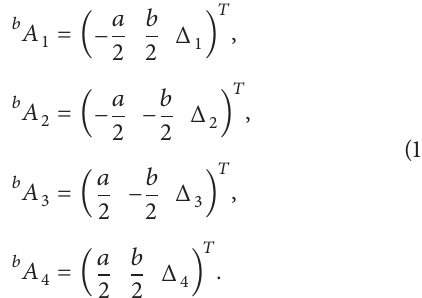
horizontal plane as datum known as 𝑛 -coordinate